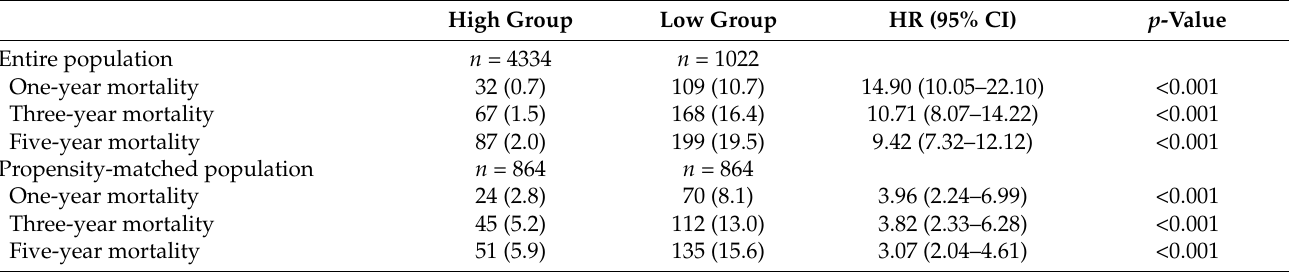
Table 3. Mortalities according to days alive and out of hospital (DAOH) <